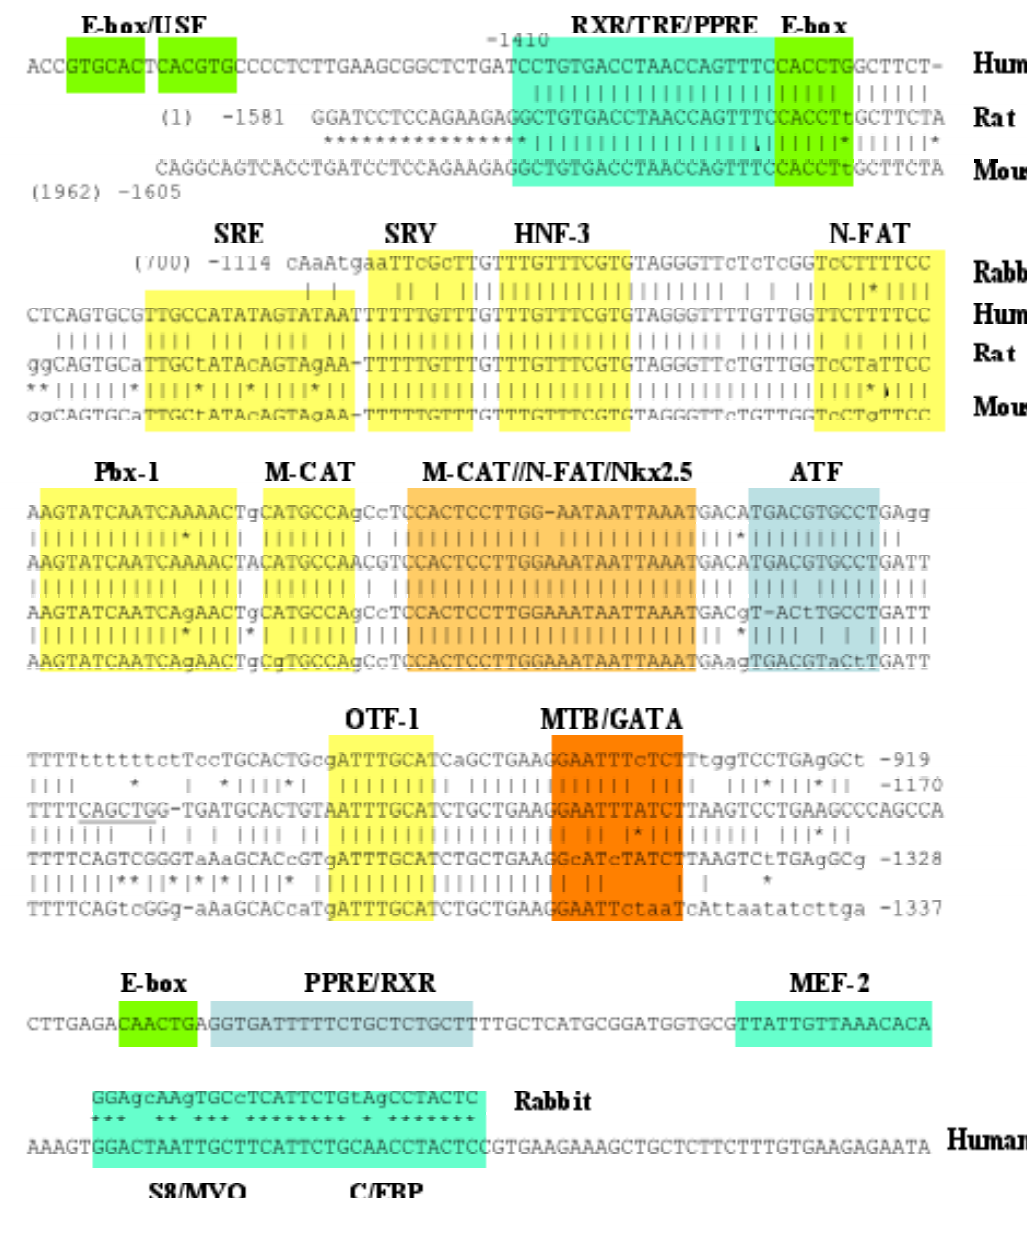
FIGURE 4. Nucleotide sequence alignment of SERCA2 gene 5’-regulatory regions. The identity in nucleotide sequence of 1.58 kb of SERCA2 regulatory sequences among human, rabbit, rat, and mouse species is indicated by a vertical line (|). An asterisk (*) indicates similarity only between two sequences. The consensus DNA sequences for various regulatory elements are shown in color areas, and ERSE is boxed. The 5’-nontranslated sequence of the first exon is in bold letters. MacVector 6.5.3, Blast NCBI, and Genomatix MatInspector Professional 5.1 were used to align sequences and to identify putative DNA binding